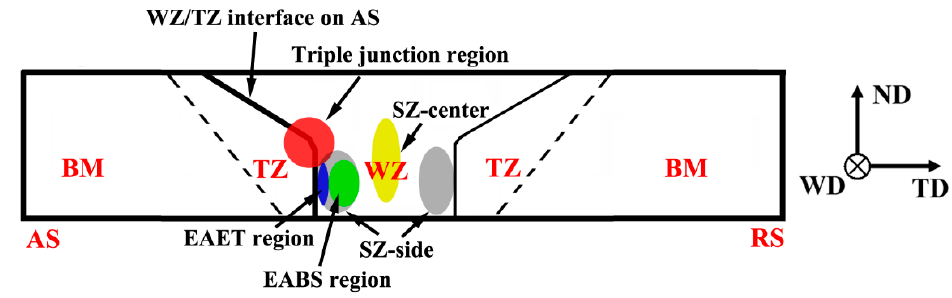
Figure 1. Schematic diagram of weak zones in FSW Mg alloys from the viewpoint of local texture.